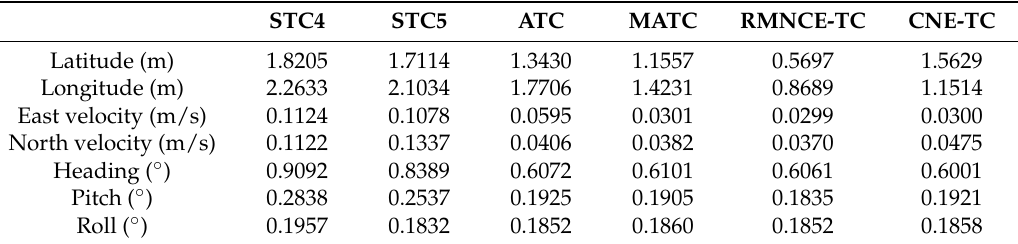
Table 8. Global RMSE values of the different schemes.